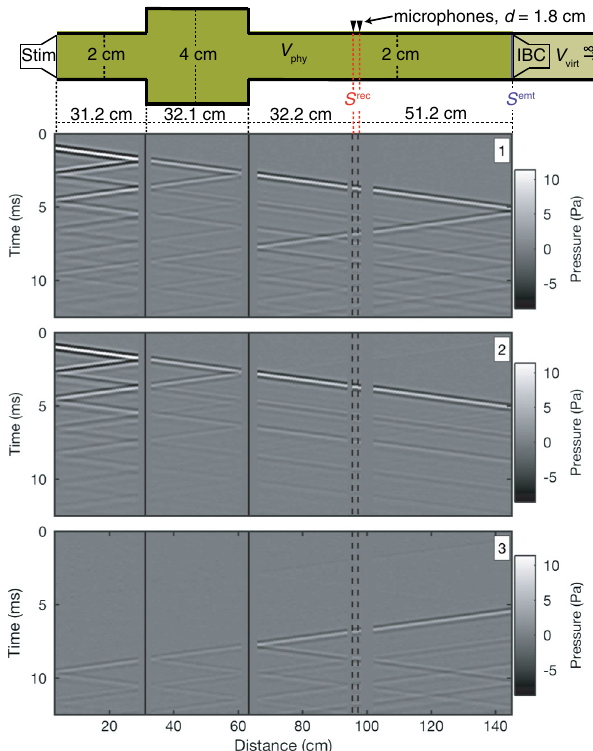
FIG. 7. Top: Geometry of the three-layer waveguide. Time- distance panel (1): Reference pressure field resulting from the emission of a Ricker wavelet with 2-kHz center frequency with inactive IBCs. Panel (2): As above, but with an active IBC source on the right. Panel (3): Difference of both pressure fields. Positions immediately next to the diameter changes and recording locations do not contain data due to practical limitations.